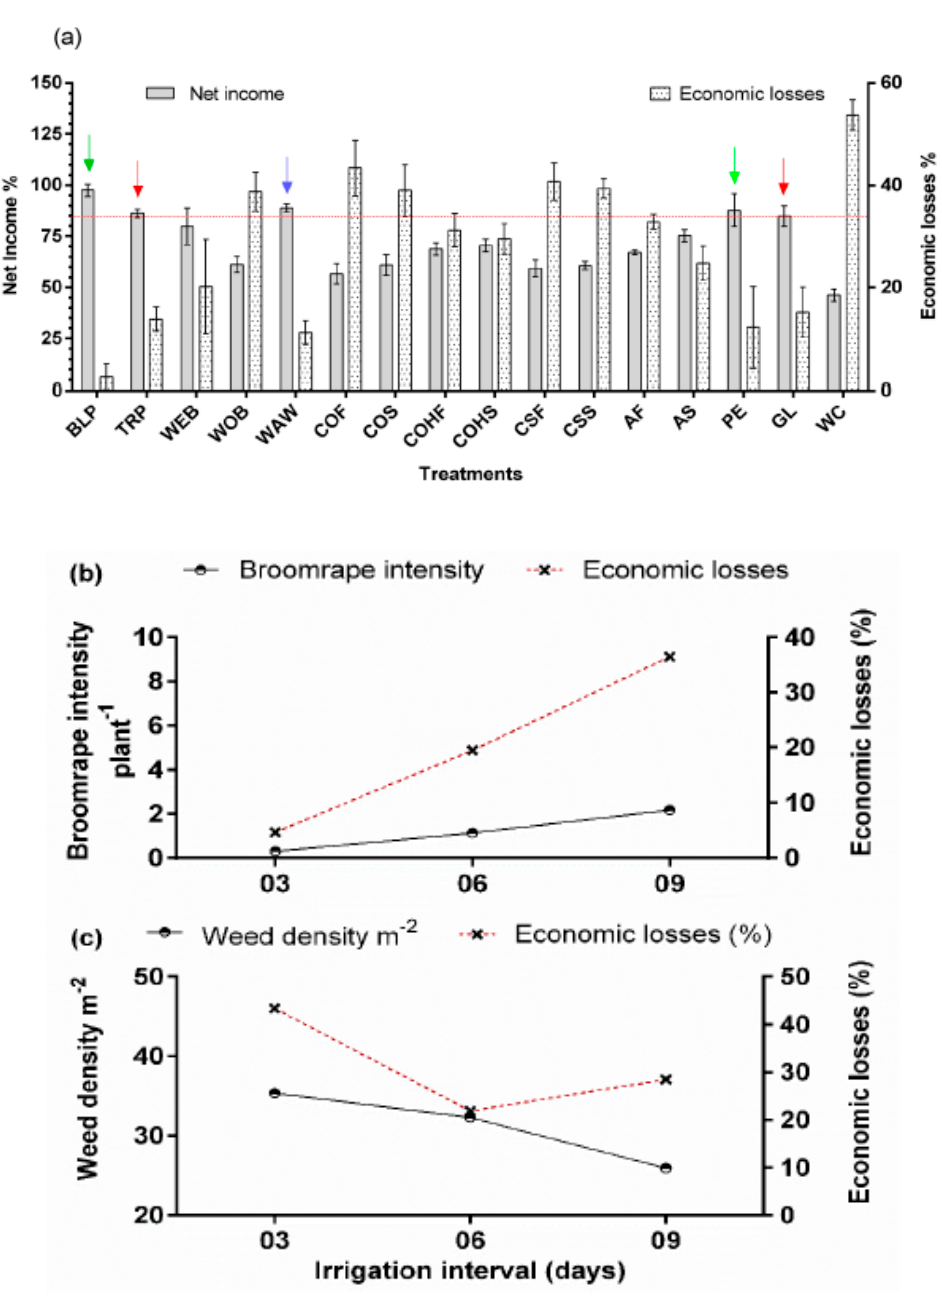
Figure 17. Net income vs economic losses% ( a ). Horizental red-color line in ( a ) shows the income level of top five treatments, above the red line indicates highest income and vice versa. Five different arrows, categorized in four different colors shows the highest income. BLP: dark-green color arrow indicates the highest income, followed by WAW: blue-color arrow, PE: light-green color arrow, where TRP and GL with red-color arrow indicated lowest income than BLP, WAW and PE respectively. Impact of various irrigation intervals on broomrape intensity plant − 1 and economic losses% ( b ). Influence of various irrigation intervals on weed density m − 2 and economic losses% ( c ). BLP: Black plastic; TRP: Transparent plastic; WEB: Weeding except broomrape; WOB: Sole Weeding of broomrape; WAW: Weeding of all weeds; COF: Copper oxychloride (Single dose) @ 2kg ha − 1 ; COS: Copper oxychloride (Split doses); COHF: Copper oxychoride + Humic acid (Single dose); COHS: Copper oxychoride + HA (split doses); CSF: Copper sulphate (single dose) @ 2kg; CSS: Copper sulphate (split doses); AF: Ammonium sulphate (single dose); AS: Ammonium (split doses); PE: